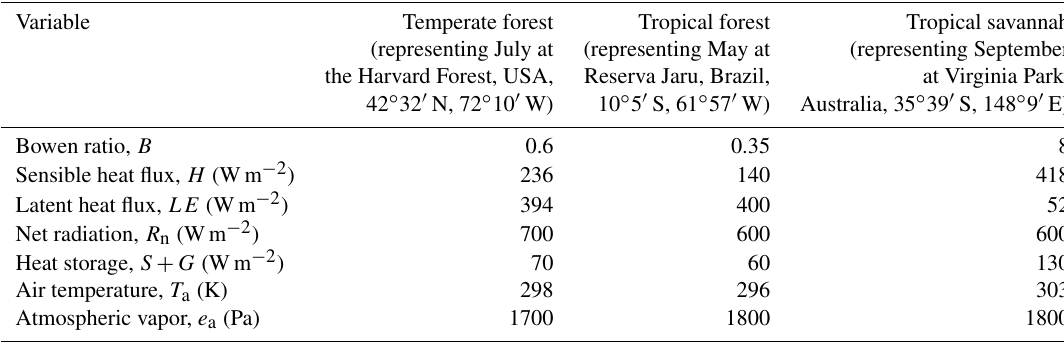
Table 1. Values of environmental and biological variables used in the error simulations (representing midday). Variable Temperate forest Tropical forest (representing July at (representing May